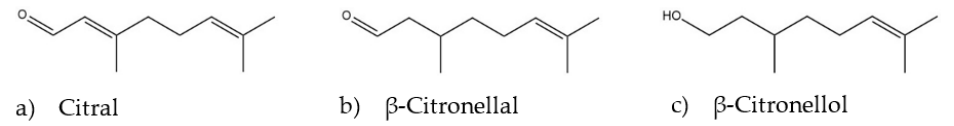
Figure 2. Structure of main components found in selected essential oils. ( a ) Citral, present in lemongrass oil; ( b ) β -citronellal, present in lemon eucalyptus oil; and ( c ) β -citronellol, present in geranium Egyptian oil.